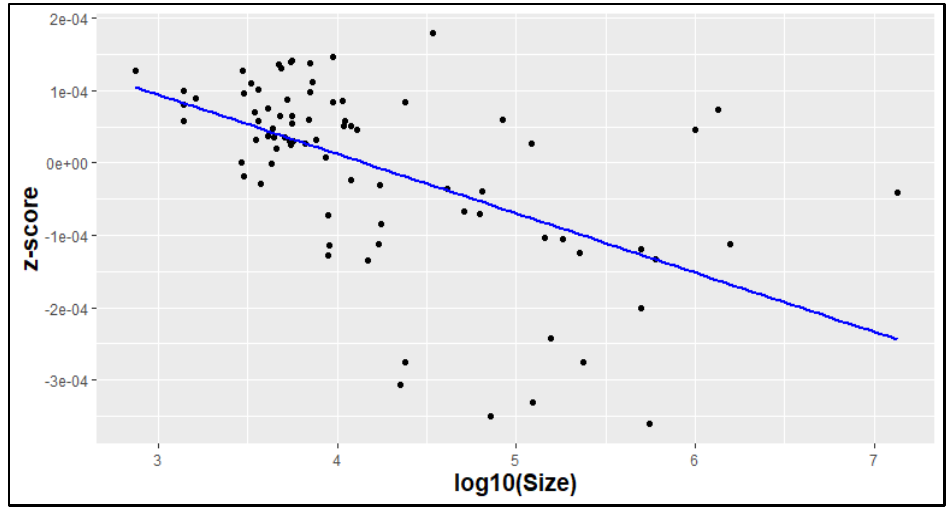
with trees (cooler-browner quadrant) were cooler than parks with grass cover (warmer- browner quadrant) of similar size. Figure 14. Log-linear regression of LST mean z-score change of Land Surface Temperature.